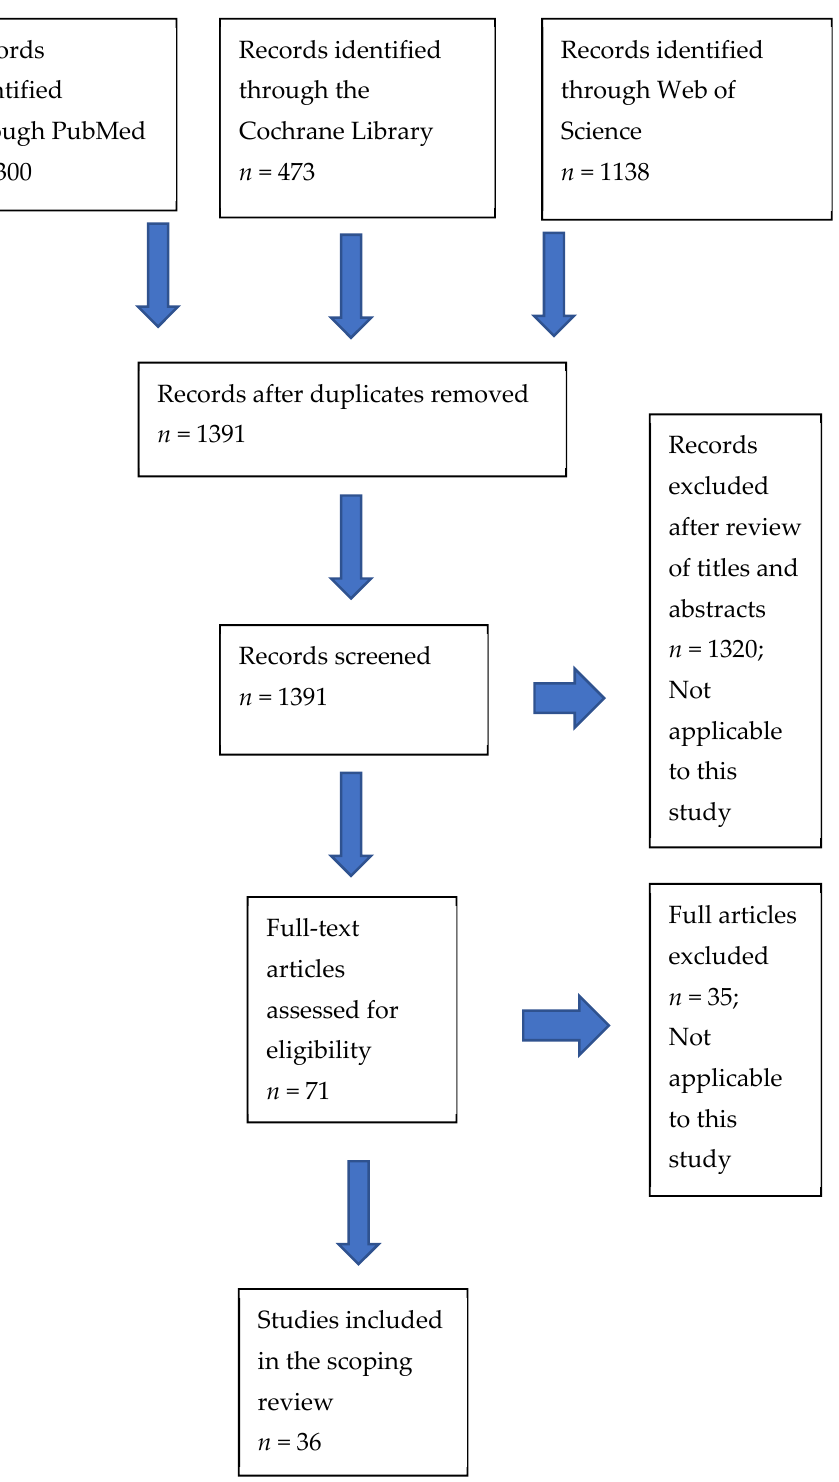
Figure 1. PRISMA diagram according to PRISMA-ScR guidelines [23].